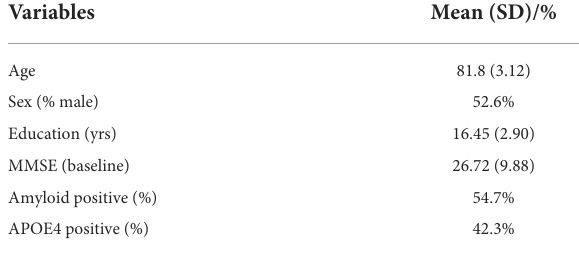
TABLE 2 Demographic characteristics of the 80 + sample longitudinal